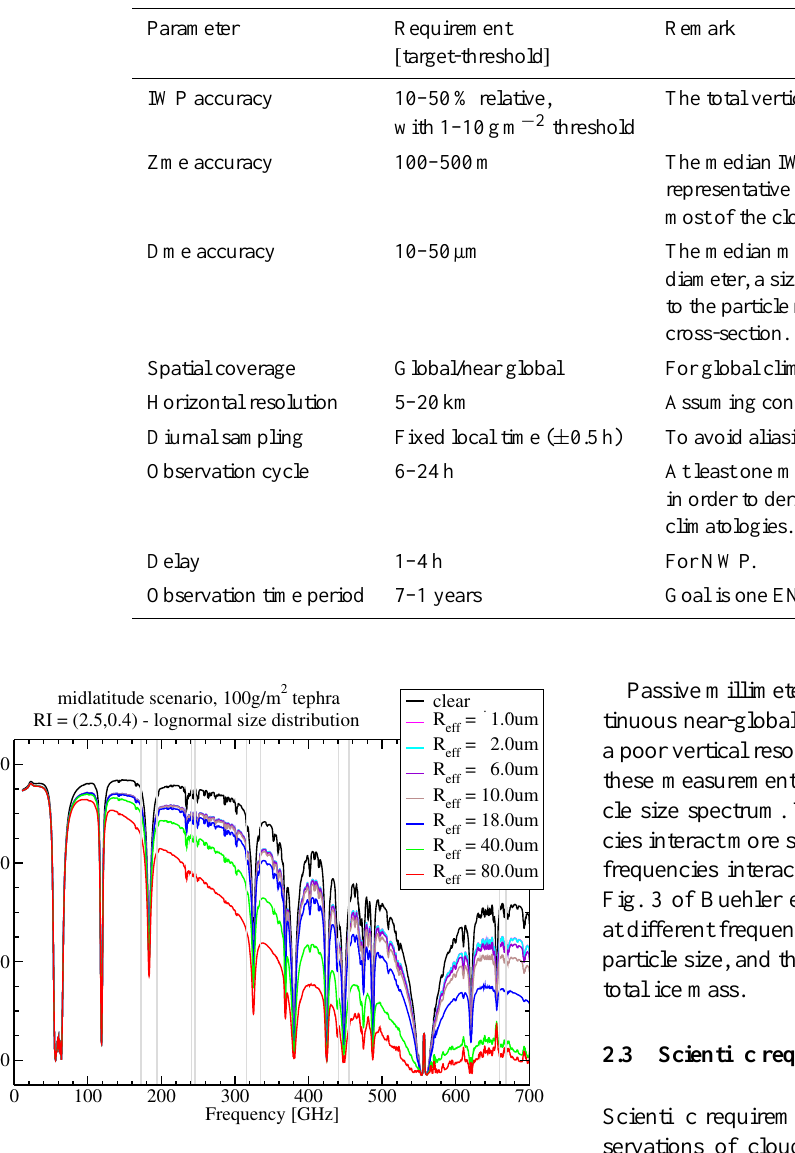
Fig. 2. Brightness temperature spectrum for a total column ash con- tent of 100gm − 2 , an assumed refractive index of 2.5+0.4i, and spherical particles with log-normal size distributions of different ef- fective